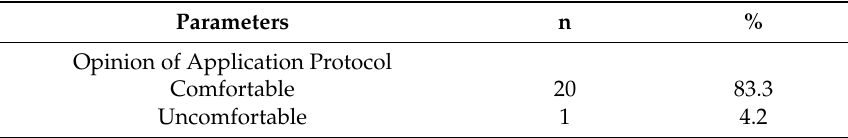
Table 7. Questionnaire results about the perception of the formulation (n = 24).